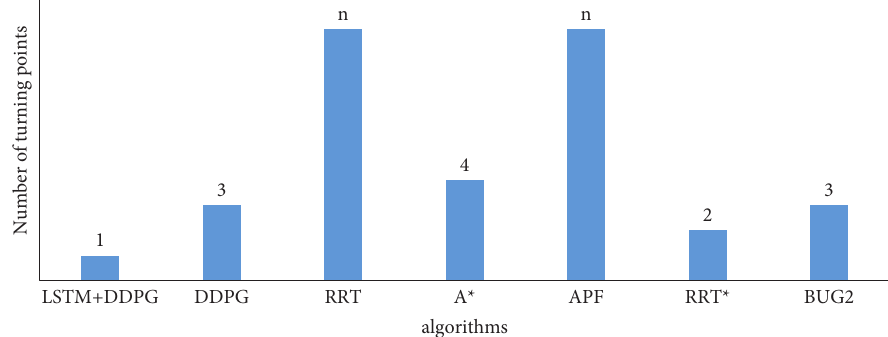
Figure 14: The number of path turning points planned by different algorithms.